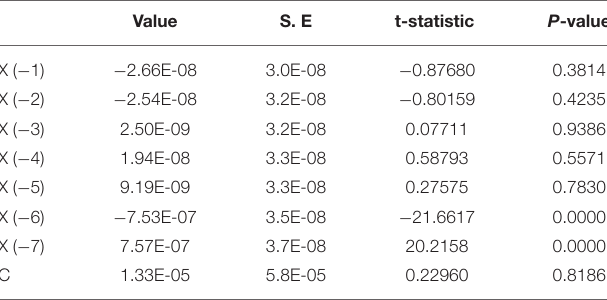
TABLE 4 | Vector autoregression estimates.